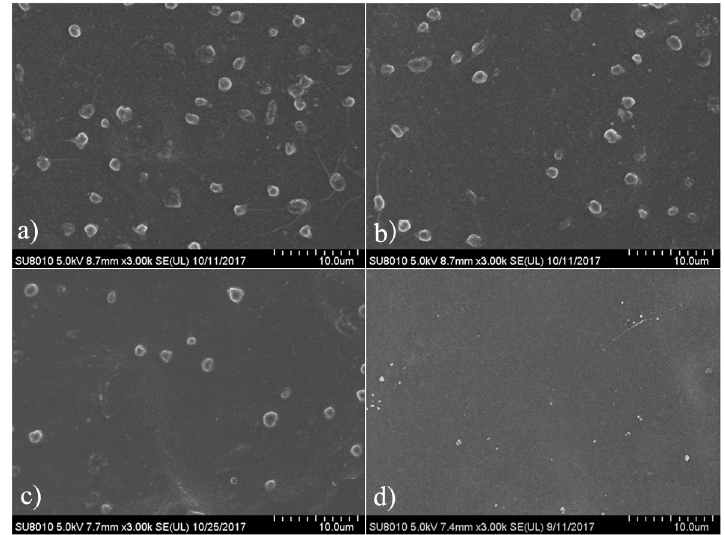
Figure 7. Representative SEM images of platelet adhesion on the surface of ( a ) PMPU-0, ( b ) PMPU-5, ( c ) PMPU-10, and ( d ) PMPU-20 films.